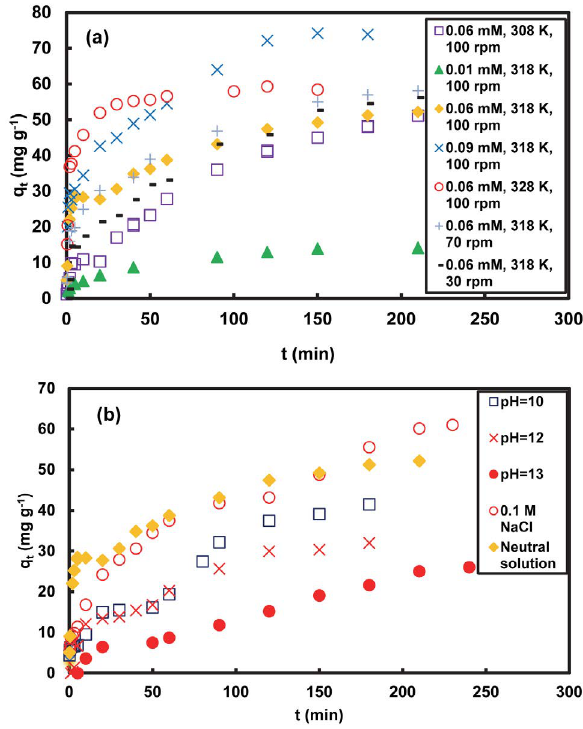
Figure 9. q t vs. c t for adsorption of CR on Mg-Al-LDH nanocom- pound (a) from CR solutions at different temperatures, shaking rates and initial concentrations and (b) from 0.06 mM CR in water, 0.1 M NaCl and alkaline solutions at 318 K and 100